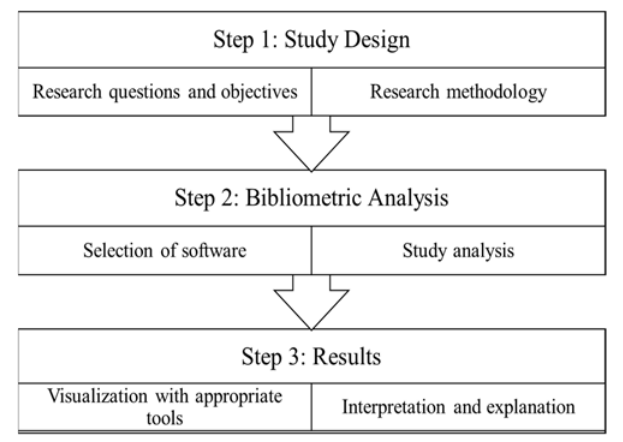
Figure 1. Workflow of study.